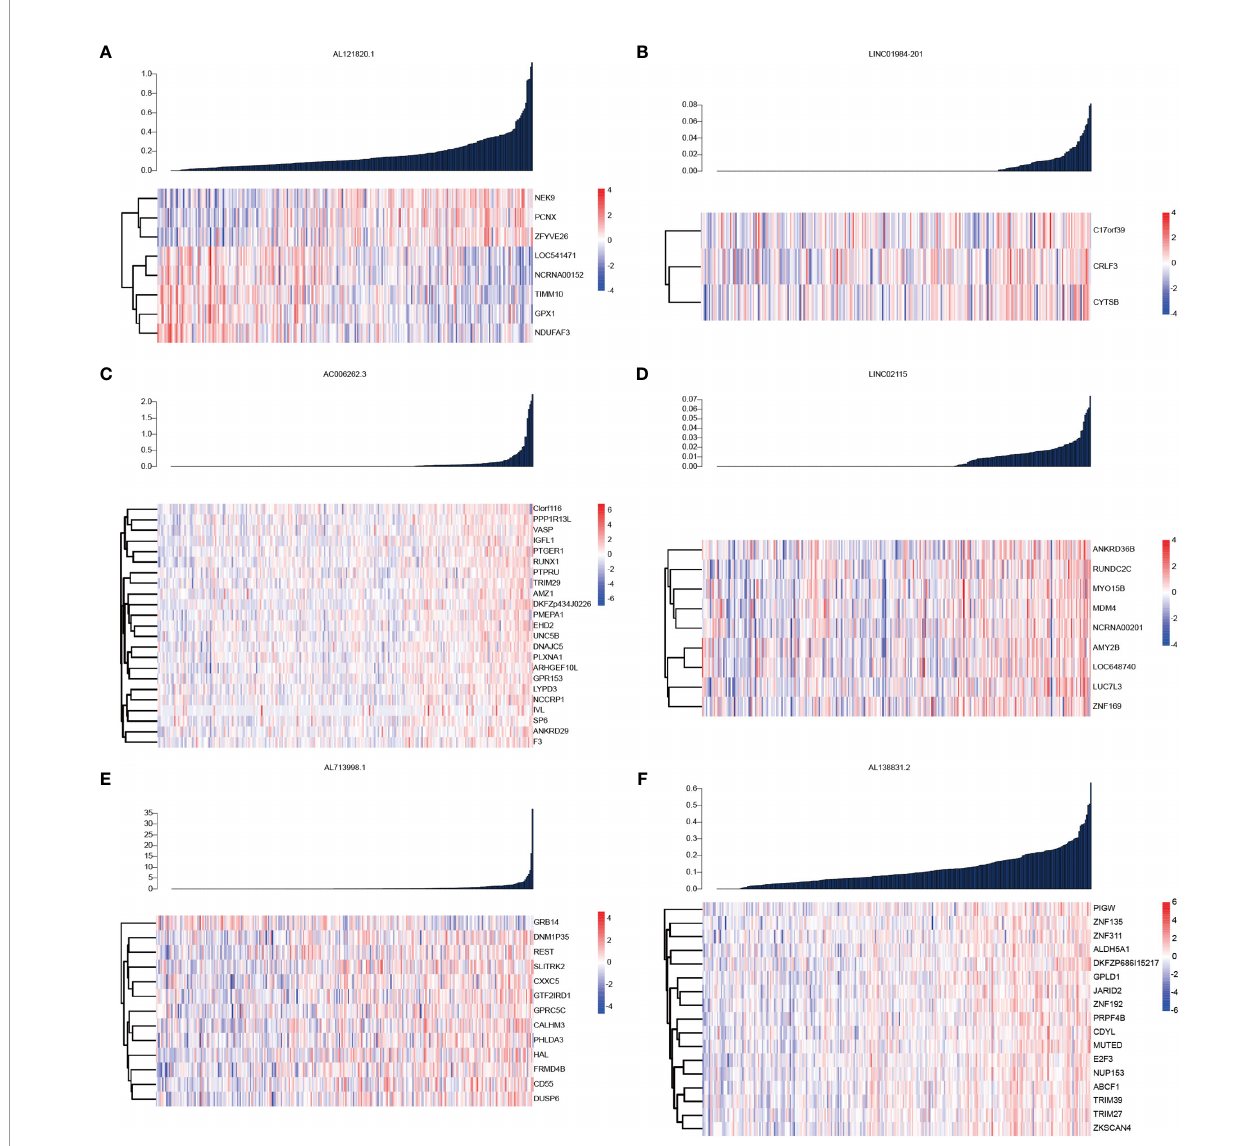
FIGURE 2 | Pearson correlation coef fi cient analysis between the expression levels of coding genes and the six lncRNAs. (A) Heatmap of the coding genes expression targeted by AL121820.1; (B) Heatmap of the coding genes expression targeted by linc01984-201; (C) Heatmap of the coding genes expression targeted by AC006262.3; (D) Heatmap of the coding genes expression targeted by linc02115; (E) Heatmap of the coding genes expression targeted by AL713998.1; (F) Heatmap of the coding genes expression targeted by